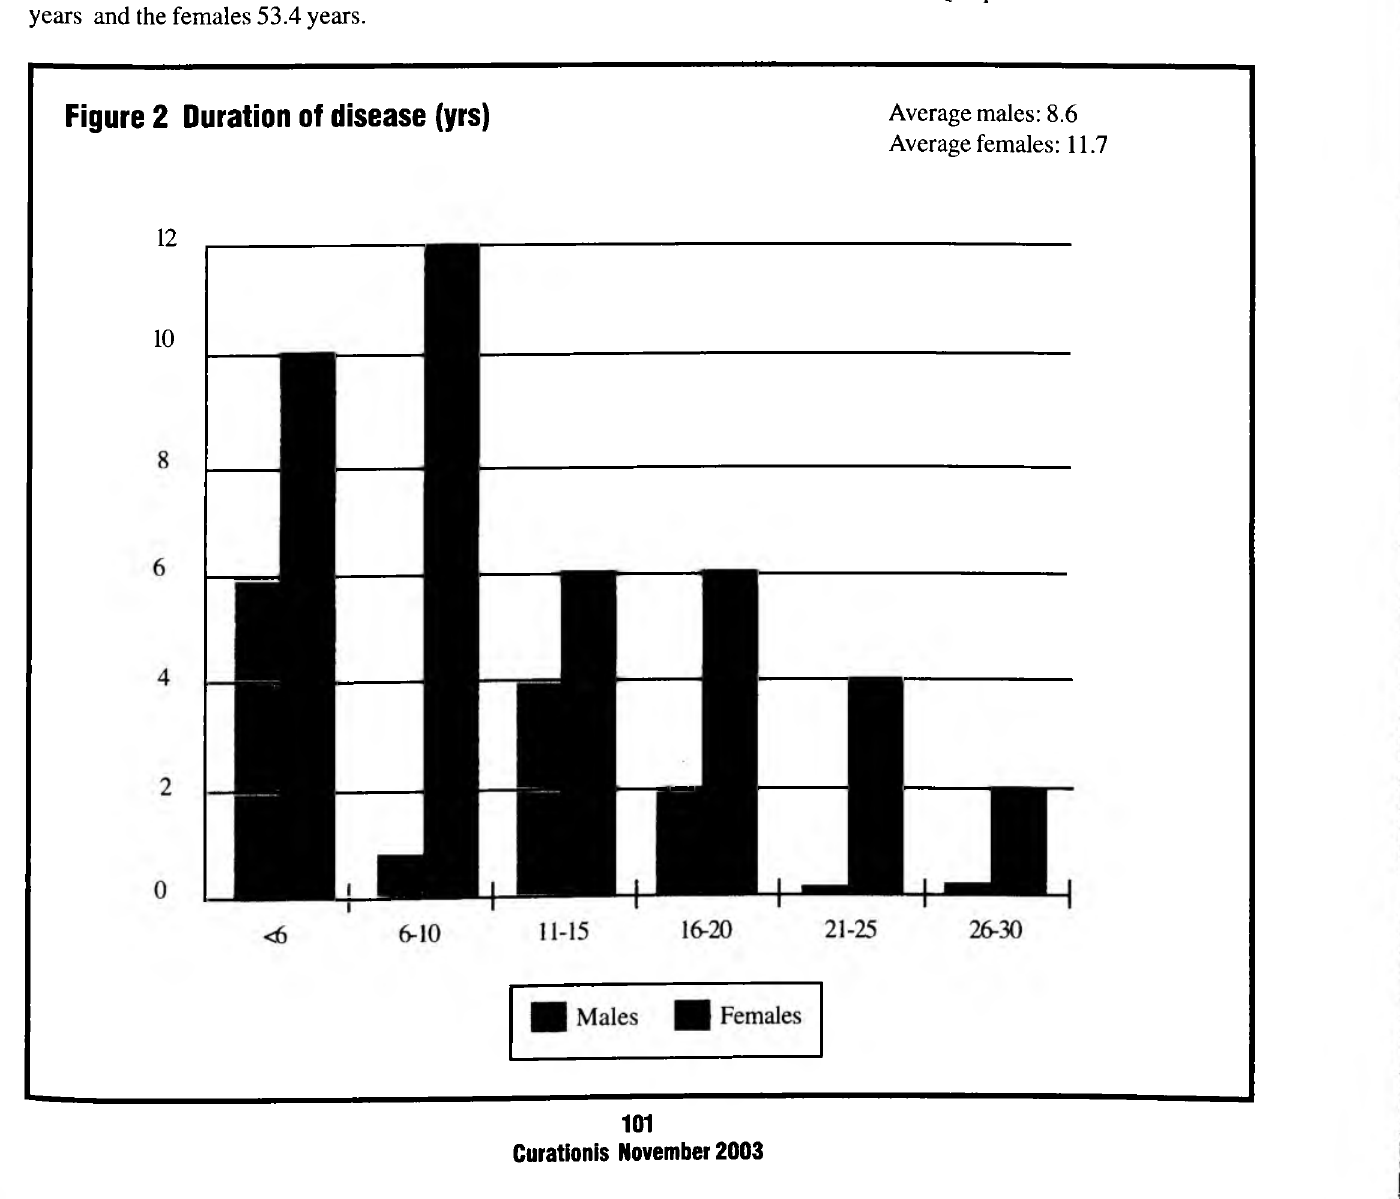
Figure 2 Duration of disease